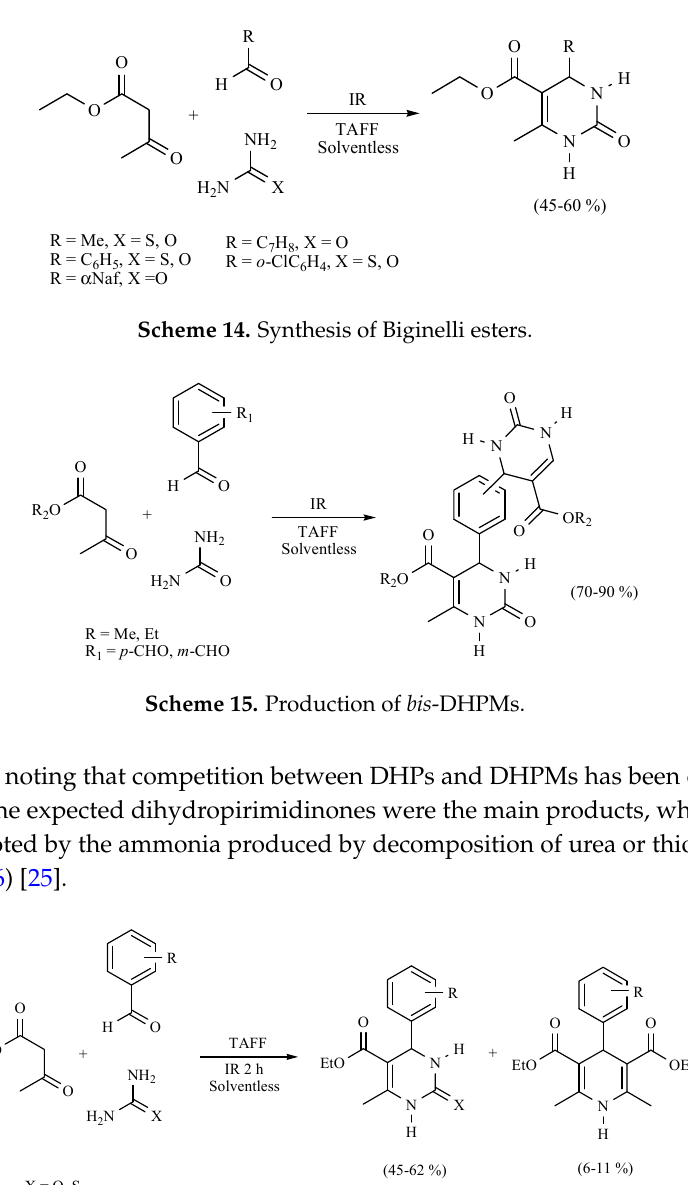
Scheme 16. Comparative formation between DHPMs and DHPs.